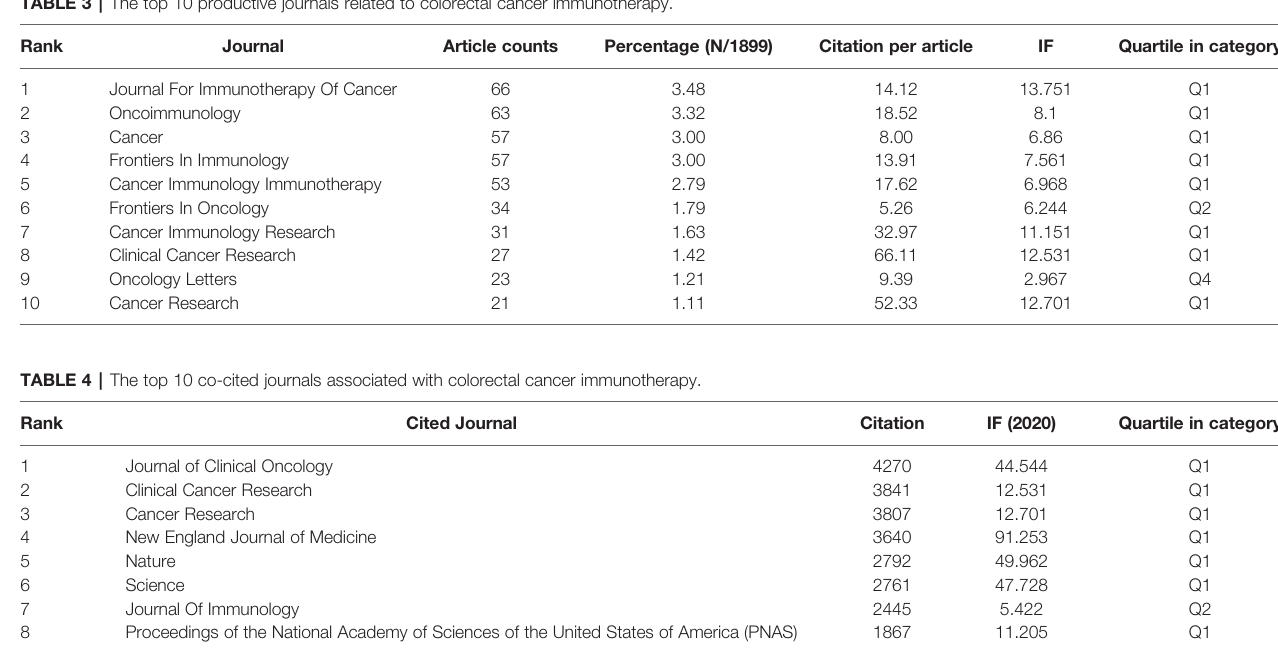
TABLE 3 | The top 10 productive journals related to colorectal cancer immunotherapy.